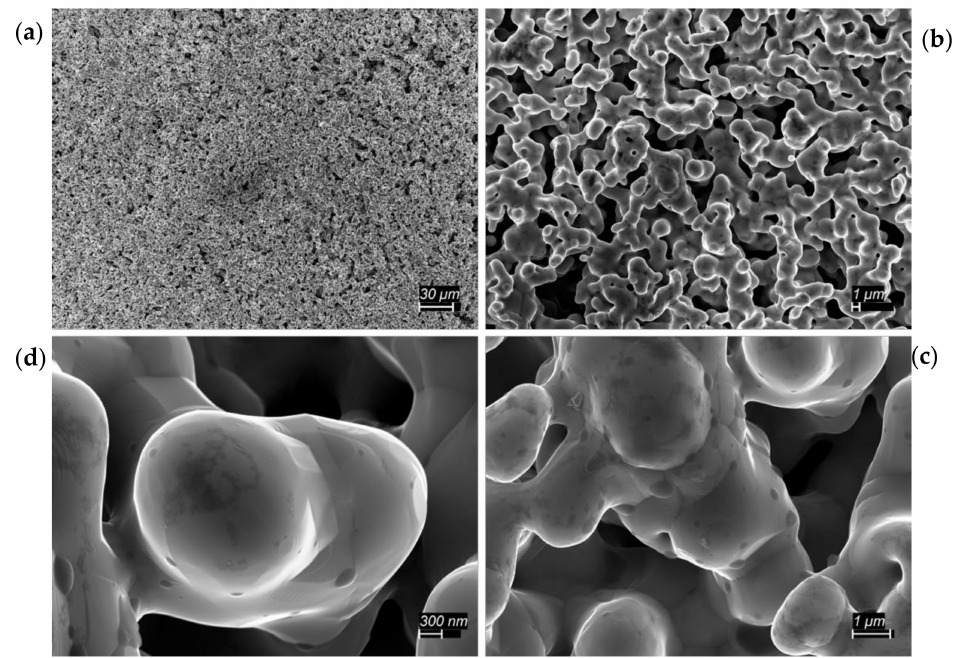
Figure 5. SEM Images of sintered 1:1 Ni:NiO part after 2nd bake. The four figures show the same area with increased magnification. Clearly, all particles are sintered together ( a ) and ( b ). There is no evidence of ‘heterogeneous’ particle composition, and no charging, consistent with conductive metal,